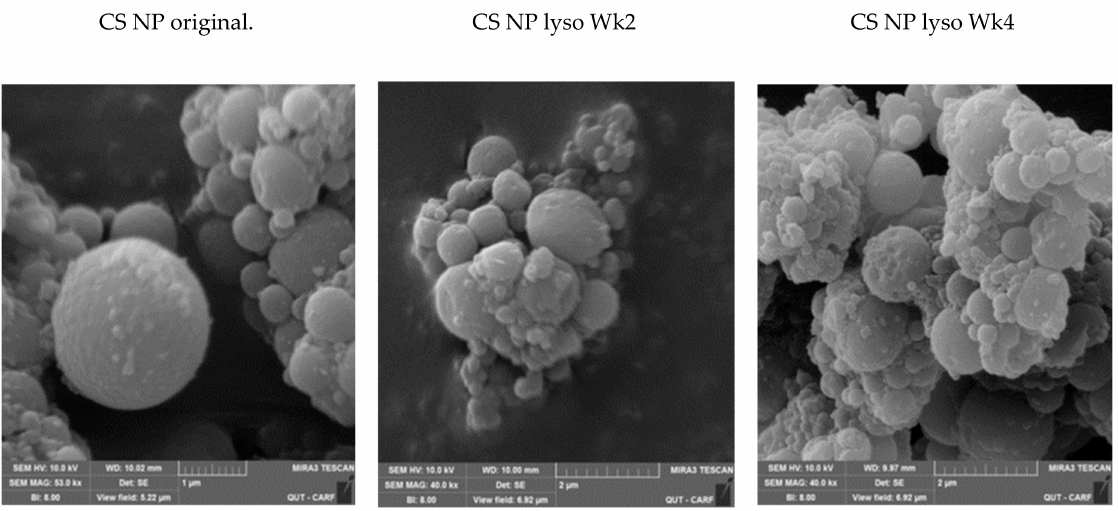
Figure 4. SEM images of CS before and after incubating in 0.2 mg/mL lysozyme solution at different time intervals.